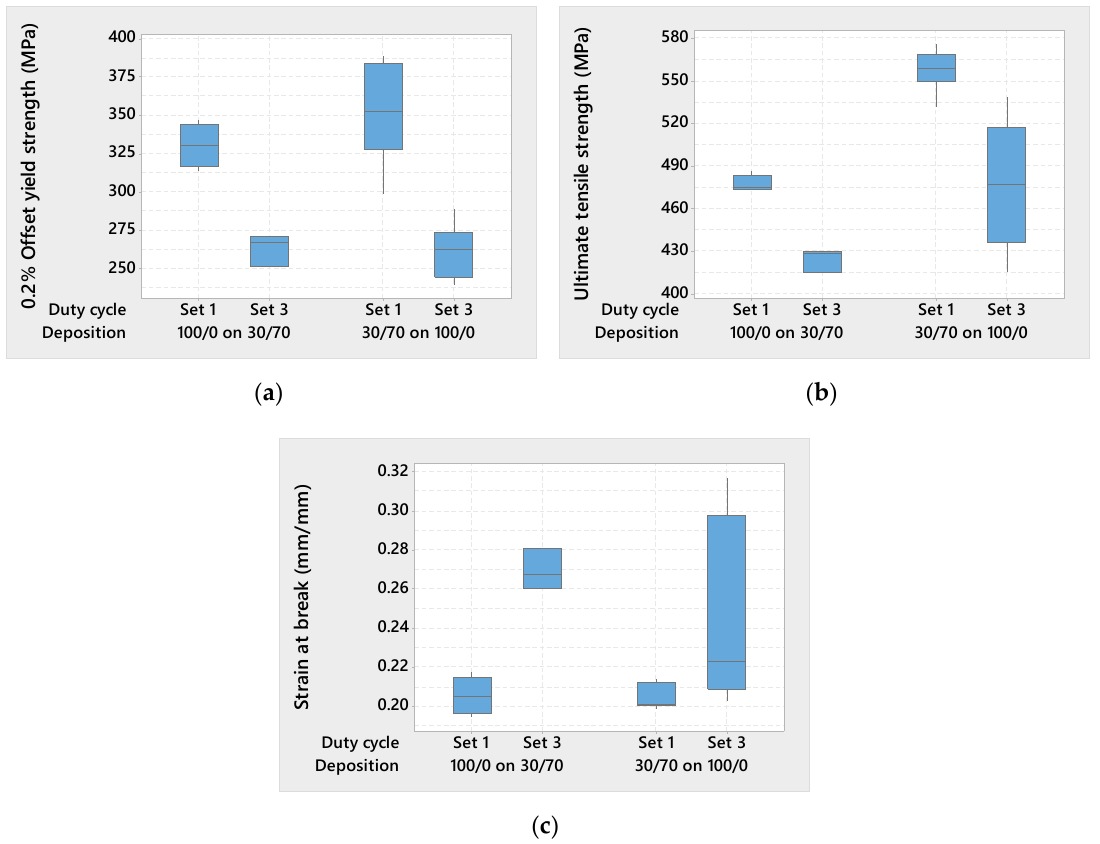
Figure 17. Box-and-whisker plots of ( a ) 0.2% offset yield strength, ( b ) ultimate tensile strength, and ( c ) strain at break from the crosshead displacement for the miniature tensile specimens prepared from deposits of different combinations. The box spans the 25th and 75th quartile, the vertical lines indicate the range between the minimum and maximum values, and the horizontal line indicates the median value.